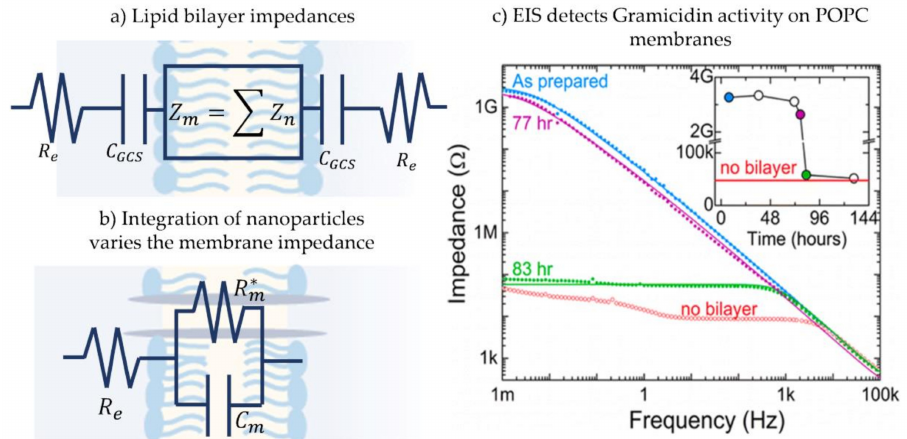
a capacitor in parallel. The electrolytes resistance Re and the capacitance of the electrical double layer C GCS are also present in the electric circuit, but the membrane impedance typically dominates the response. However, the double layer itself and its surrounding can be divided into tuned impedance layers depending on the hypothesis in question and each layer is detected through varying frequencies. ( b ) A common electrical circuit when investigating channel-forming proteins in membranes: the electrolyte solution resistance, R e , in series with membrane capacitance, C m , and membrane resistance, R m . The latter is variable in the presence of membrane-protein